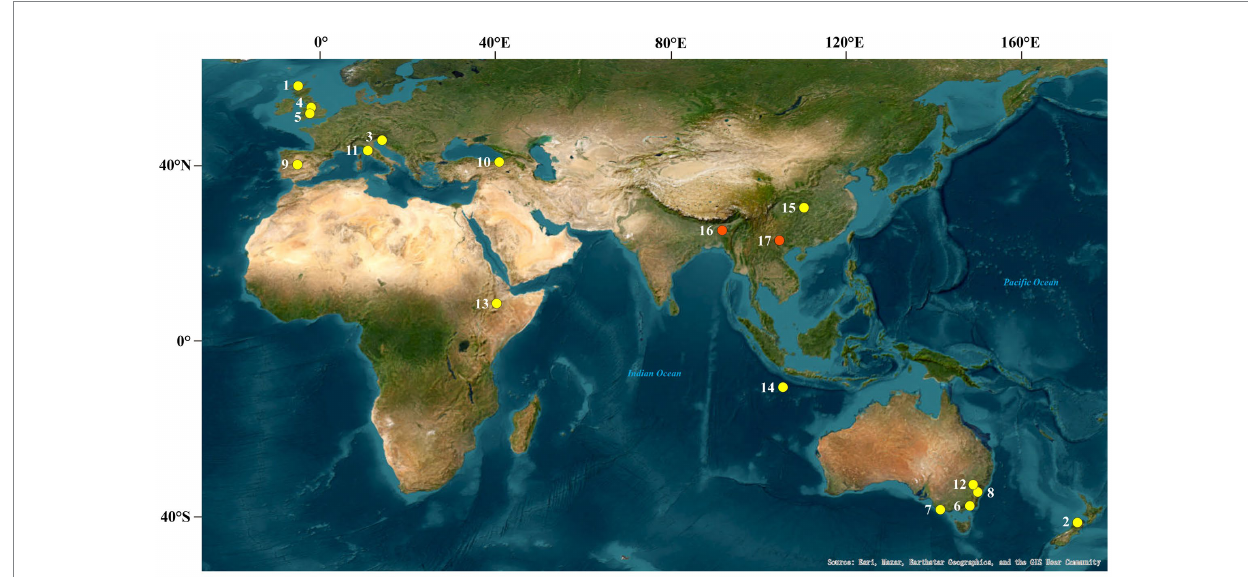
FIGURE 1 Global cave locations of published GDGT-based studies (1, Uamh am Tartair, Scotland; 2, Nettlebed Cave; 3, Postojna Cave; 4, Pooles Cavern; 5, Lower Balls Mine; 6, Buchan Caves; 7, Bats Ridge Cave System; 8, Wombeyan Caves; 9, Eagle Cave; 10, Turkey; 11, Tuscany, Italy; 12, Cathedral Cave and Gaydon Cave; 13, Achere Cave and Rukessia Cave; 14, Christmas Island; 15, Heshang Cave; 16, Mawmluh Cave; 17, Jiangjun Cave. The yellow dots 1–15 are sites of modern-process studies: Yang et al., 2011; Blyth and Schouten, 2013; Baker et al. 2019; and the red dots 16–17 are sites of paleoclimatic studies: Huguet et al., 2018; Wassenburg et al., 2021).